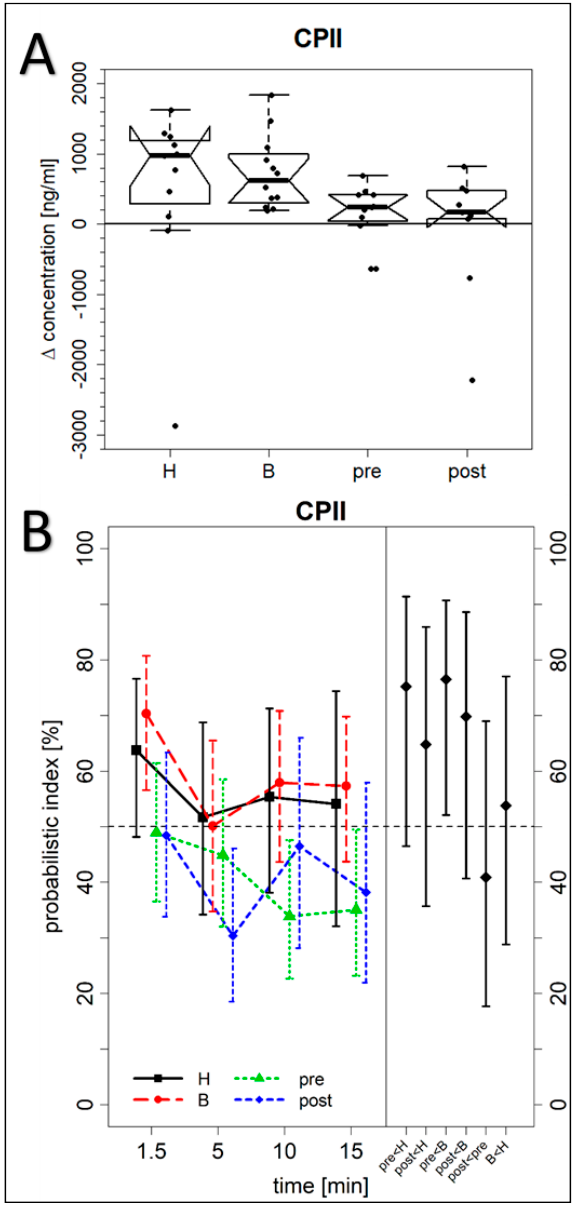
Figure 3. Serum concentrations of CPII. ( A ) The difference between the maximum biomarker concentration within the first 15 min after exercising of the hand and finger joints and the CPII level at baseline before exercising (H = cohort of patients with more Heberden-accentuated hand OA ( p = 0.007, n = 12); B = cohort of patients with more Bouchard-accentuated hand OA ( p = 0.005, n = 12); pre = premenopausal control group ( p = 0.28, n = 12); and post = postmenopausal control group ( p = 0.50, n = 12)). For further details see the caption of Figure 2A. ( B ) Fully analogous to Figure 2B, but here for CPII concentrations.